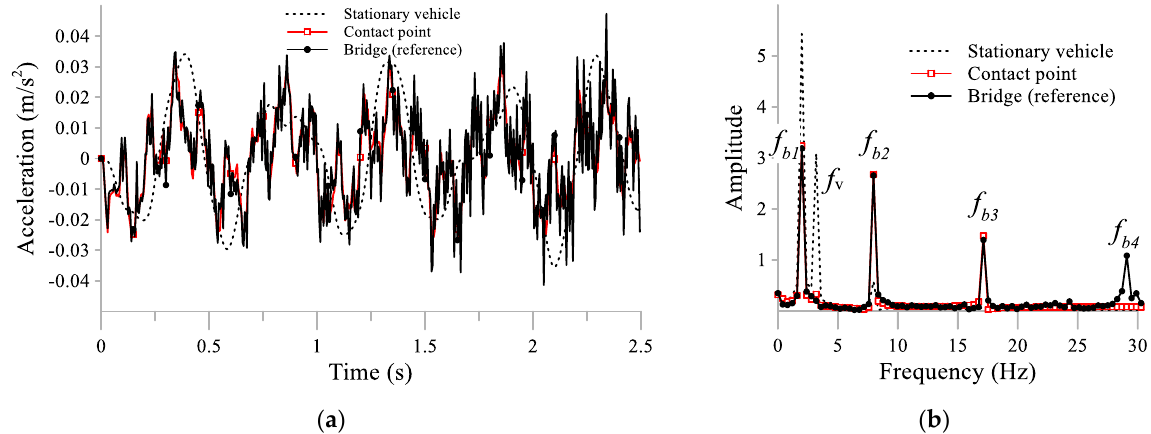
Figure 11. Dynamic responses of an undamped stationary vehicle, along with its contact point and bridge ( a ) acceleration responses when located at the first quarter of the bridge. ( b ) Acceleration spectra.